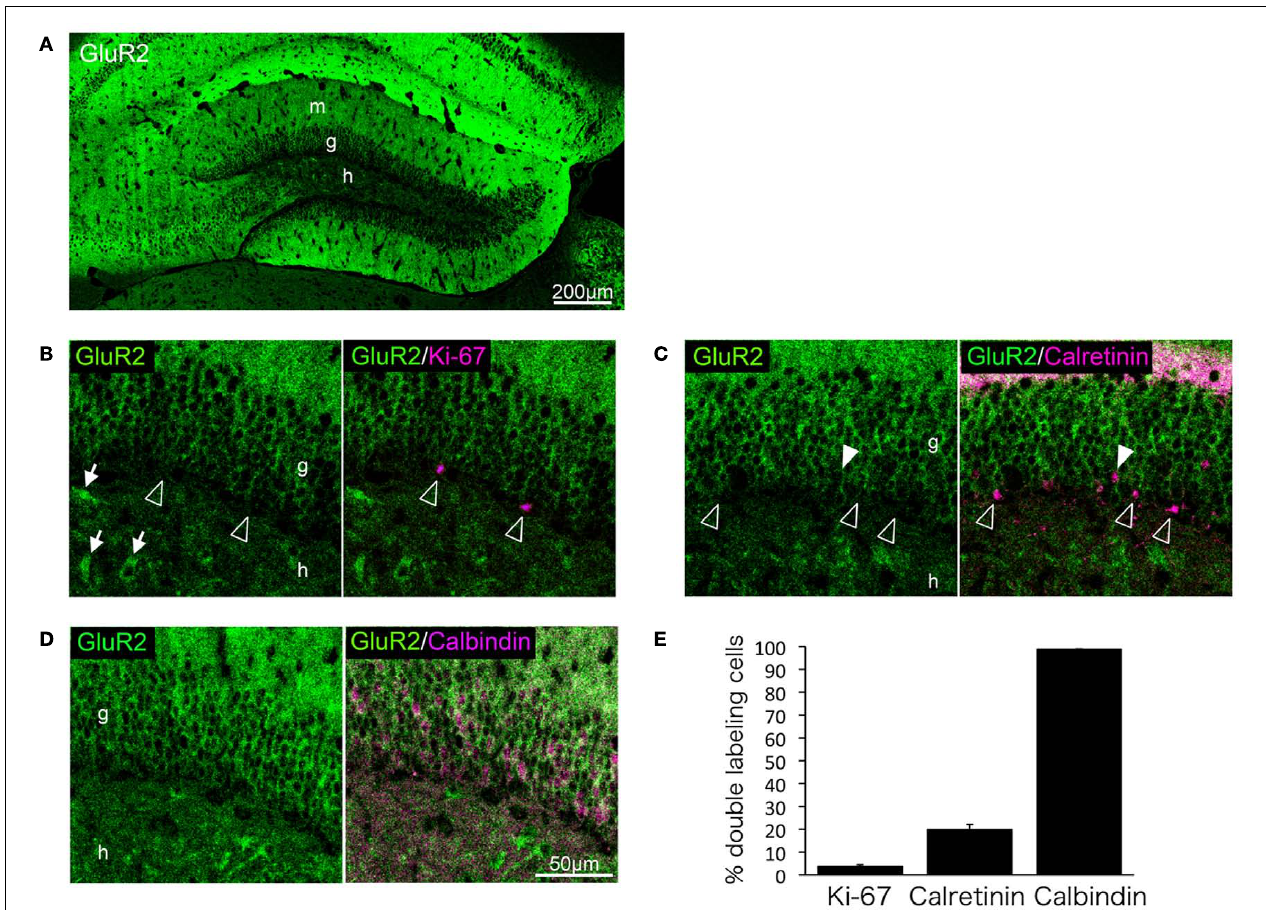
GluR2-negative cells. Filled arrowheads indicate GluR2-positive cells. (E) The co-labeled cells were quantified.Values are given as the mean ± SEM of the analysis based on the results of three mice. g, Granule cell layer; h, hilus; m, molecular